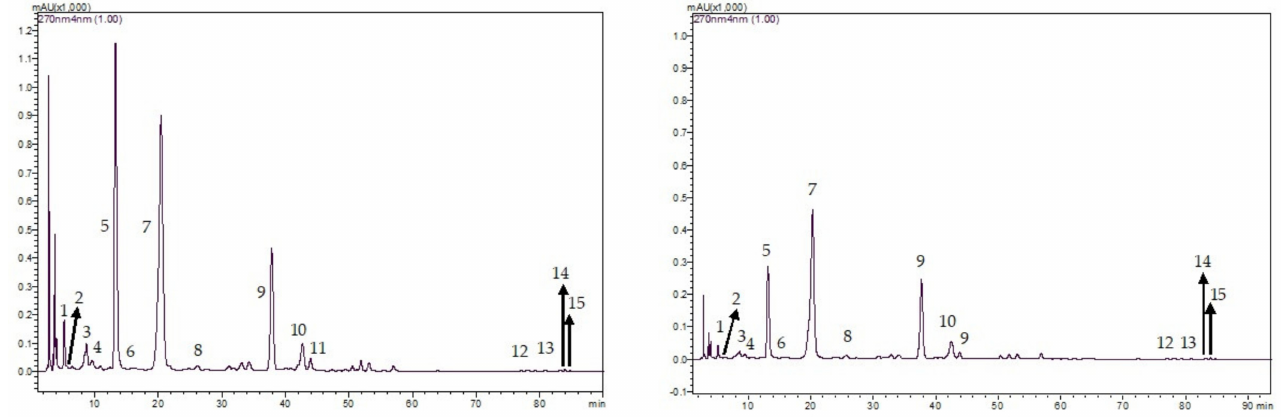
Figure 1. Example HPLC chromatograms of BTL ( left ) vs. SBTL ( right ) samples: (1) Theobromine, (2) gallocatechin, (3) epigallocatechin, (4) catechin, (5) Caffeine, (6) epicatechin, (7) epigallocatechin gallate, (8) gallocatechin gallate, (9) epicatechin gallate, (10) catechin gallate, (11) Rutin, (12) theaflavin, (13) theaflavin-3-gallate, (14) theaflavin-3 (cid:48) -gallate, and (15) theaflavin-3,3 (cid:48) -digallate.